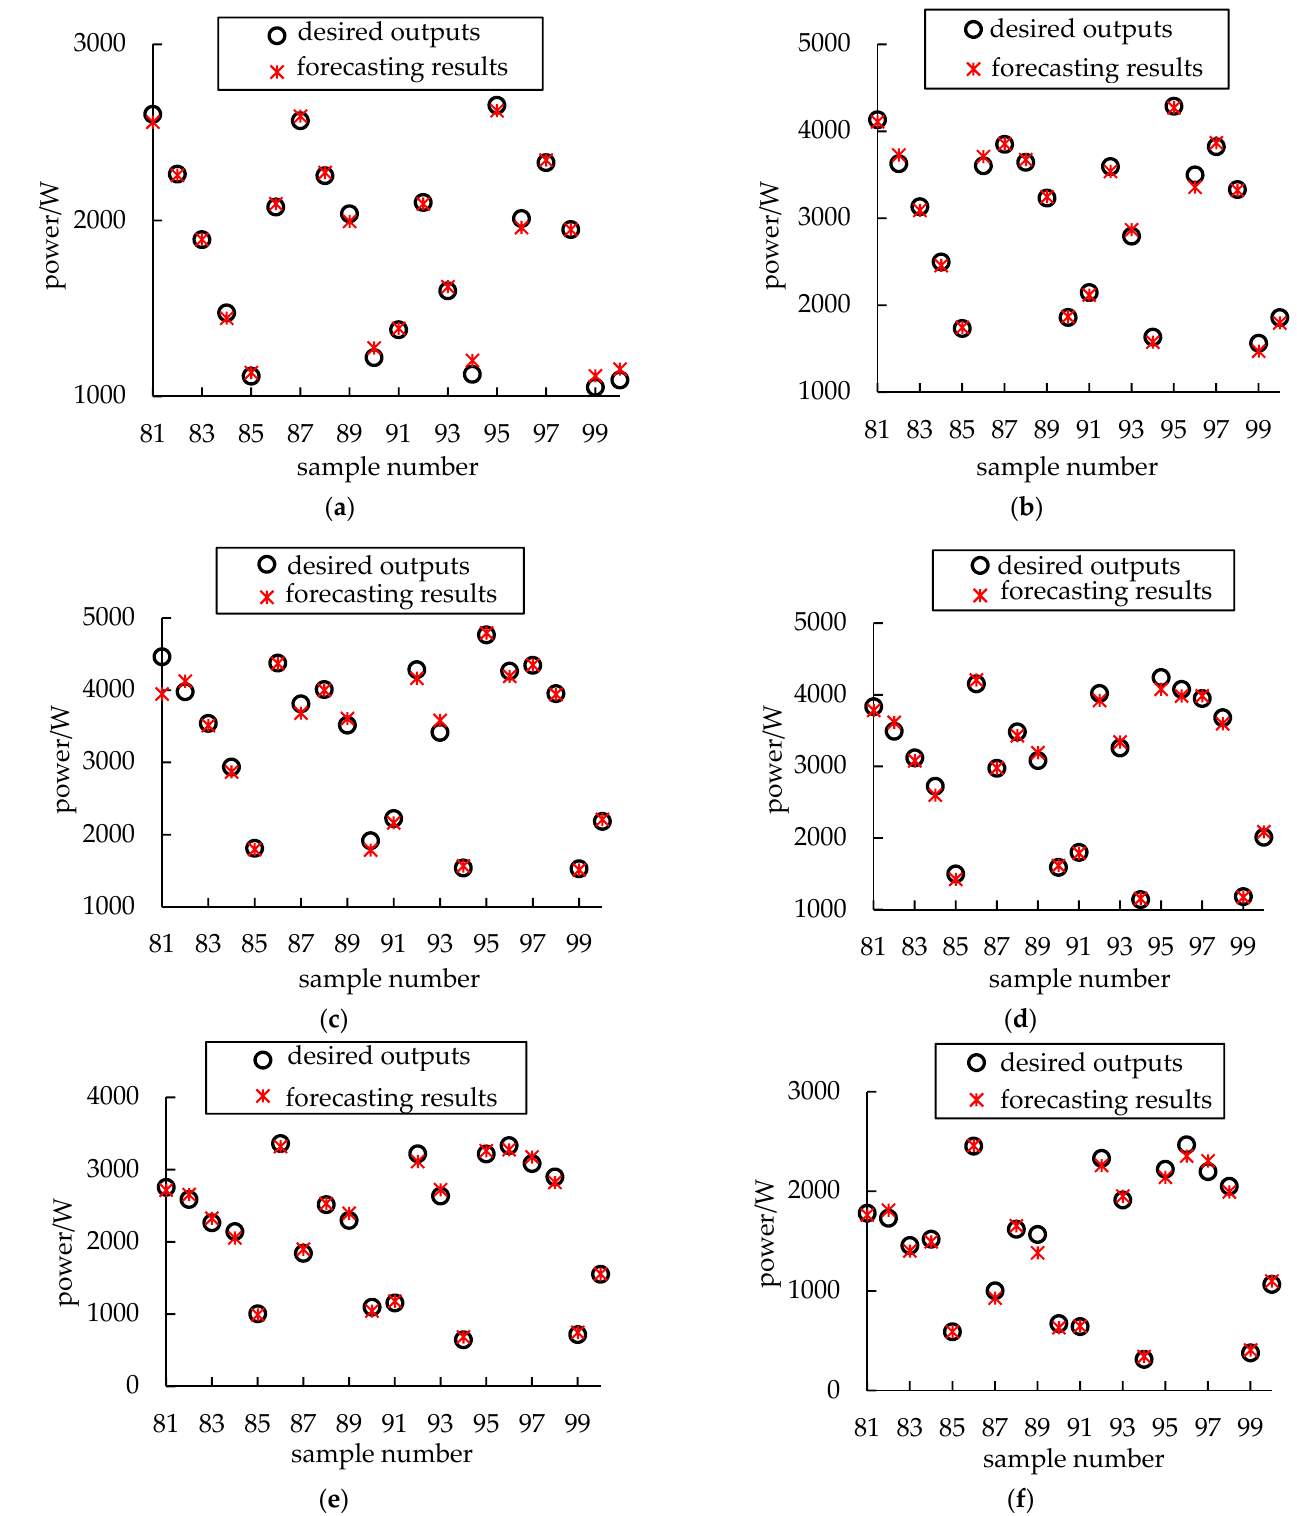
Figure 9. Comparisons between desired outputs and forecasting results. ( a ) ω = 0.53 rad/s; ( b ) ω = 0.81 rad/s; ( c ) ω = 1.14 rad/s; ( d ) ω = 1.42 rad/s; ( e ) ω = 1.76 rad/s; ( f ) ω = 2.09 rad/s.